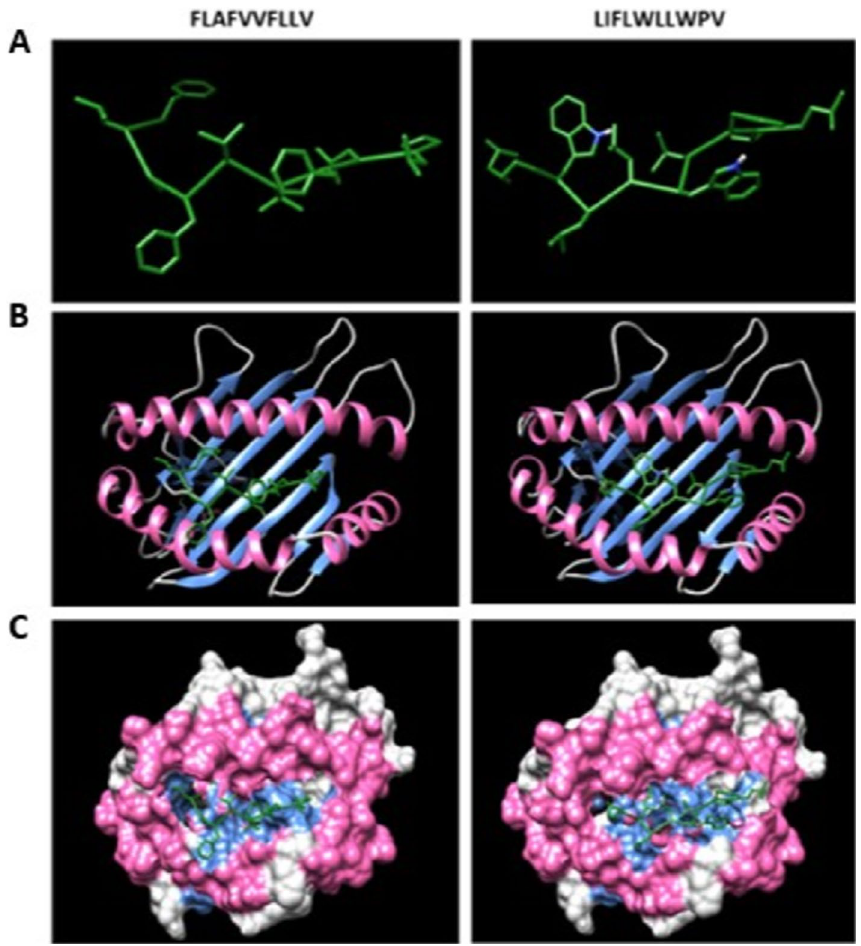
Figure 2. ( A ) Predicted FLAFVVFLLV and LIFLWLLWPV epitopes docking to MHC-I alleles. ( B ) Docking results of epitopes with α chain of MHC-I alleles using ClusPro. ( C ) The snapshot representing the epitope docked in the pocket of molecular surface of the receptor (all the structures are visualised using Chimera